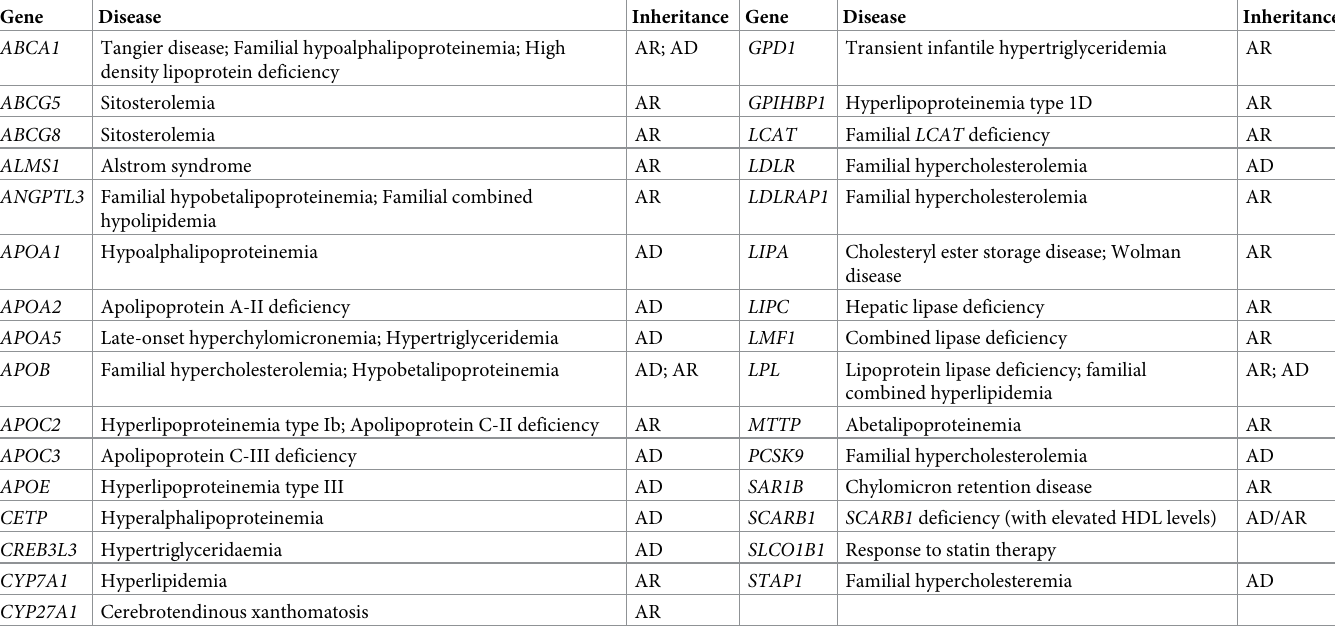
Table 1. List of genes included in the familial dyslipidemia panel.